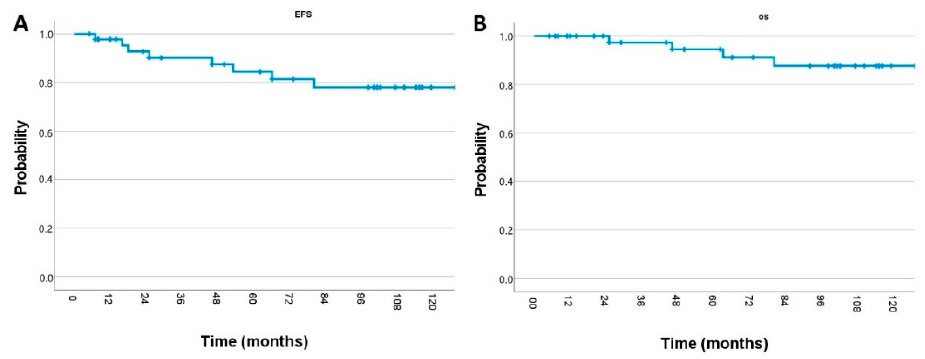
Figure 1. Kaplan–Meier estimate of ( A ) event-free survival and ( B ) overall survival of medulloblastoma patients.